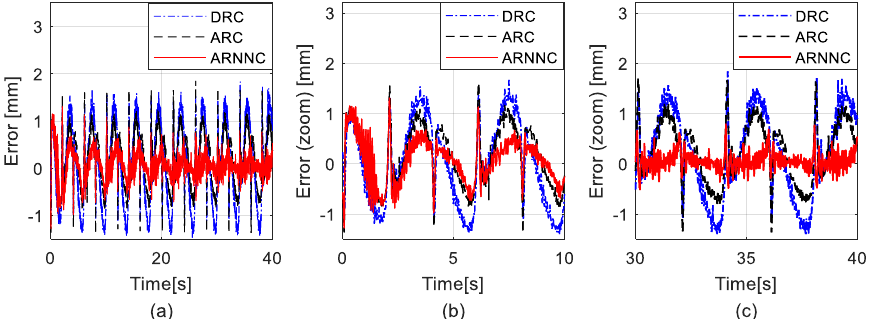
Figure 6. Tracking performances of 90Sin ( 0.5 π t − 0.5 π ) ( a ) Tracking errors of di ff erent controllers. ( b ) Zoomed tracking errors from 0 to 10 s. ( c ) Zoomed tracking errors from 30 to 40 s.